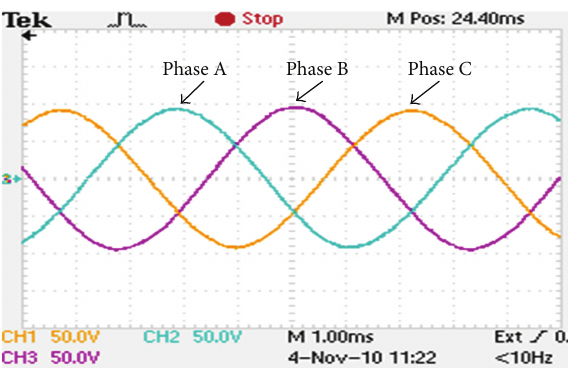
Figure 8: Measured three-phase output voltages at no-load.